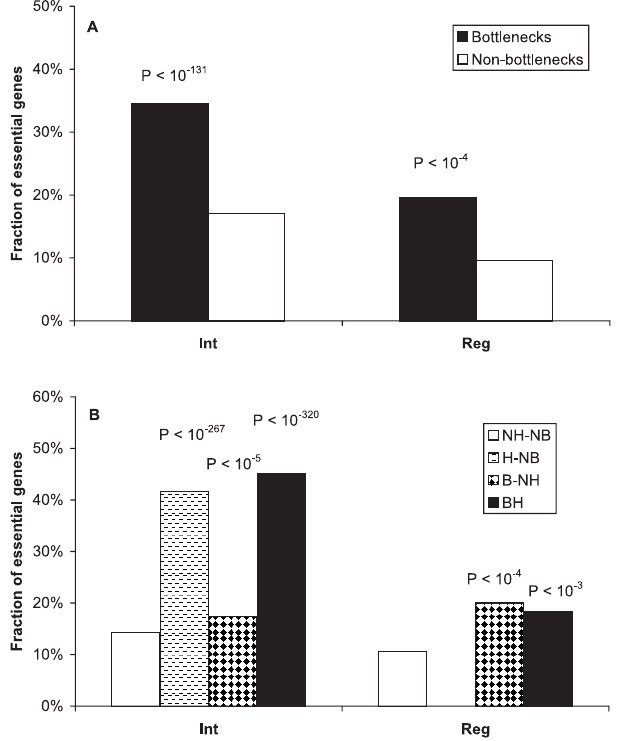
Figure 2. Comparison of Essentiality among Various Categories of Proteins within Interaction and Regulatory Networks (A) Bottlenecks tend to be essential genes in both interaction and regulatory networks. p- Values measure the statistical significance of the different essentialities between bottlenecks and nonbottlenecks. (B) Essentiality of different categories of proteins. NH-NB, nonhub– nonbottlenecks; H-NB, hub–nonbottlenecks; B-NH, nonhub–bottlenecks; BH, hub–bottlenecks. p- Values measure the statistical significance of the different essentialities between different categories of proteins against nonhub–nonbottlenecks using cumulative binomial distributions (see Methods).